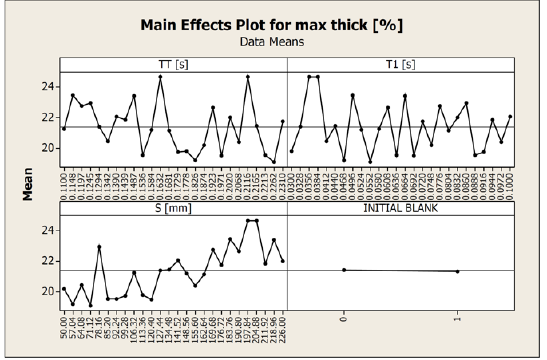
Figure 17. MEP for max thick % output.